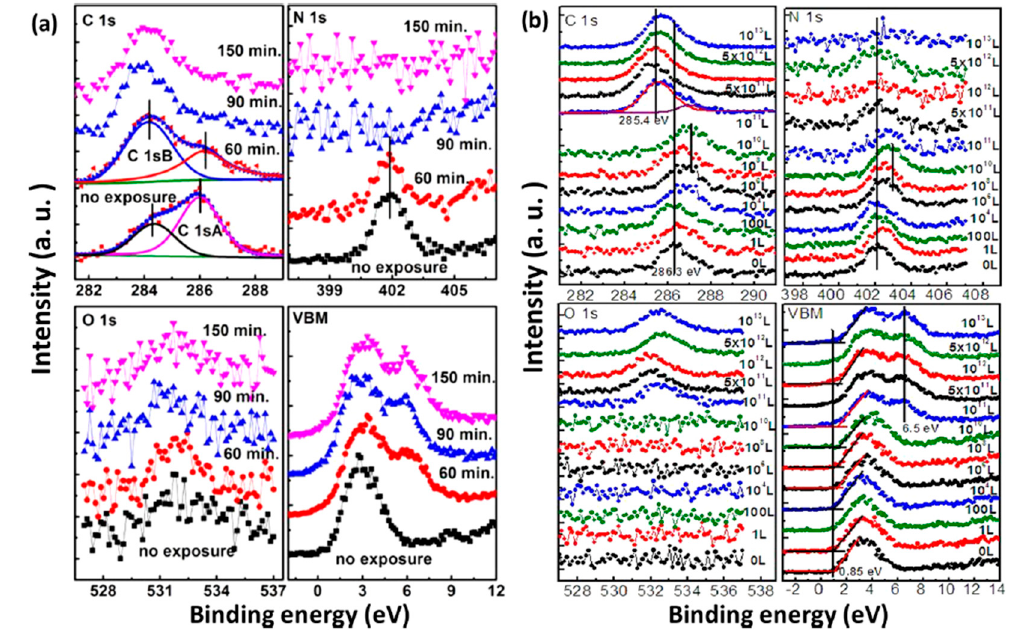
Figure 4. XPS spectral evolutions of C 1s, N 1s, O 1s, and the VBM region of evaporated MAPbI 3 thin film during ( a ) atmospheric air exposure and ( b ) H 2 O exposure. From Ref. [37]. with permission.